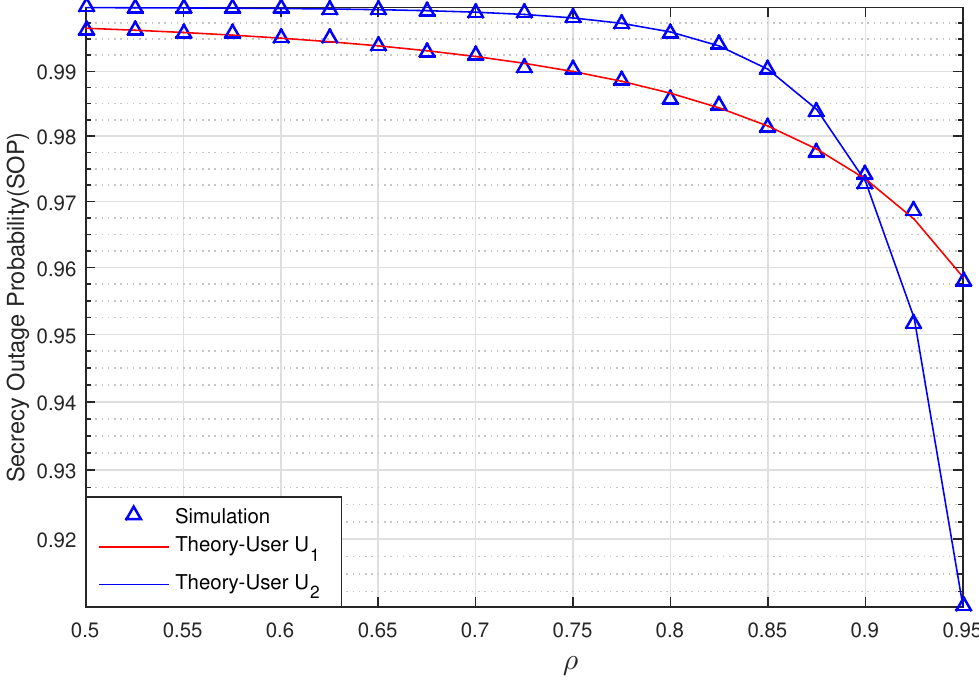
Figure 4. The SOP of U 1 and U 2 via ρ when SNR = 10